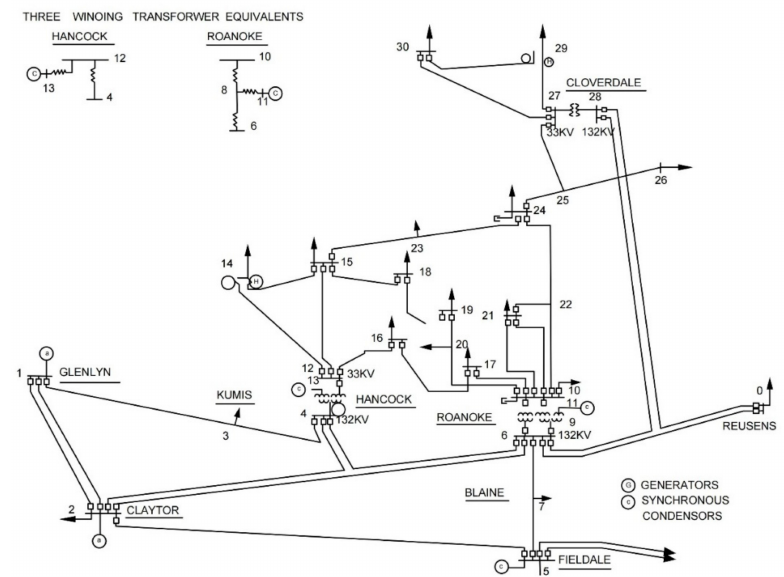
Figure 17. The IEEE 30-bus diagram.